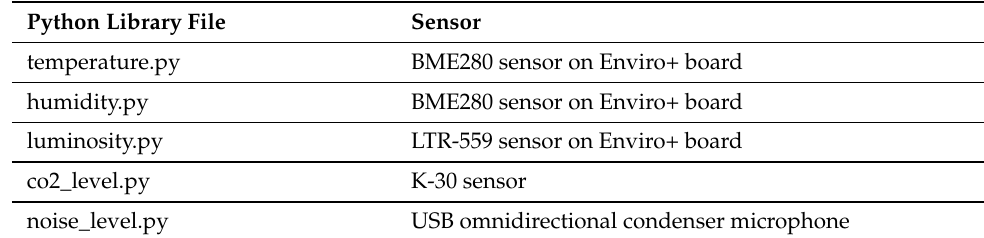
Table 4. Python files and corresponding sensors.